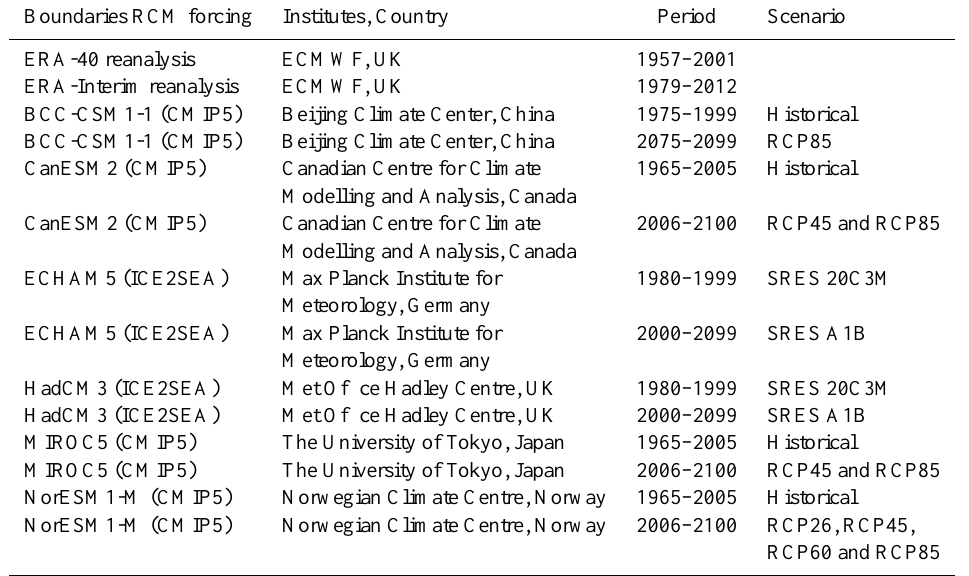
Table 1. Summary of the different forcings and scenarios used in the MAR